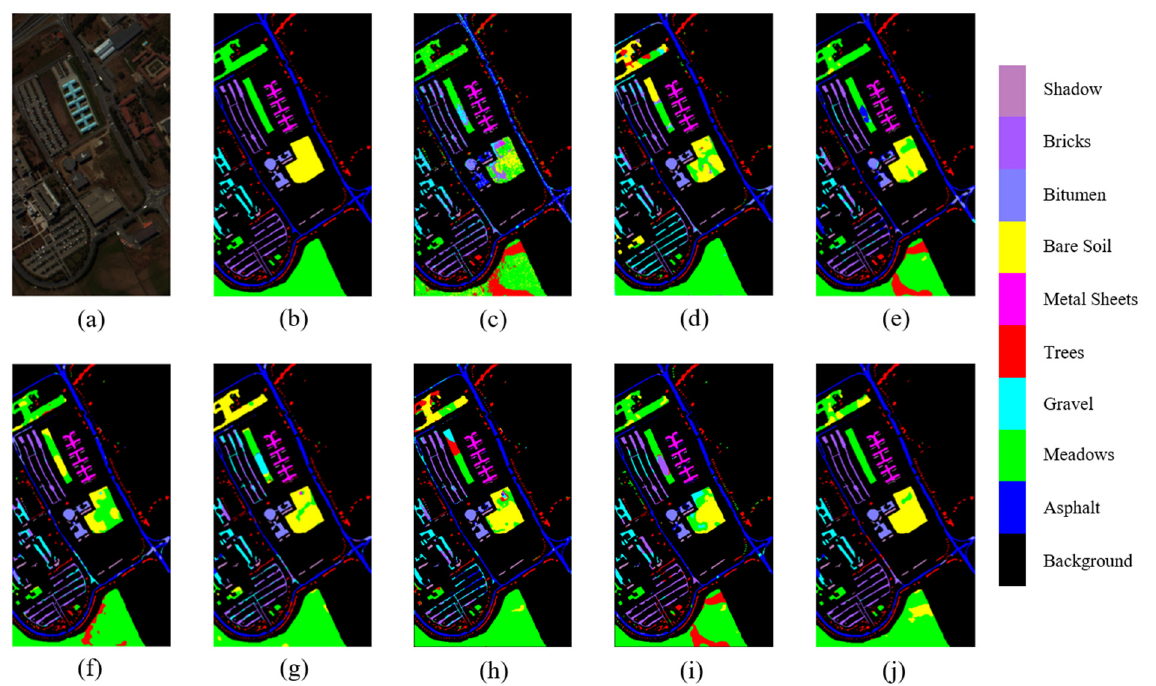
Figure 16. Classification maps of various HSI classification methods on the UP dataset. ( a ) False-Color maps. ( b ) Ground Truth. ( c – j ) SVM, SSRN, RSAKGN, DFSL+NN, DFSL+SVM, DCFSL, FSL-EGNN, and GDAFSL, respectively.